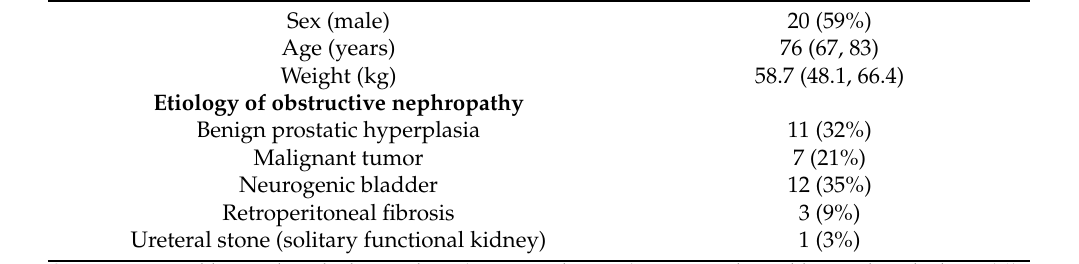
Table 1. Patient characteristics ( n = 34).